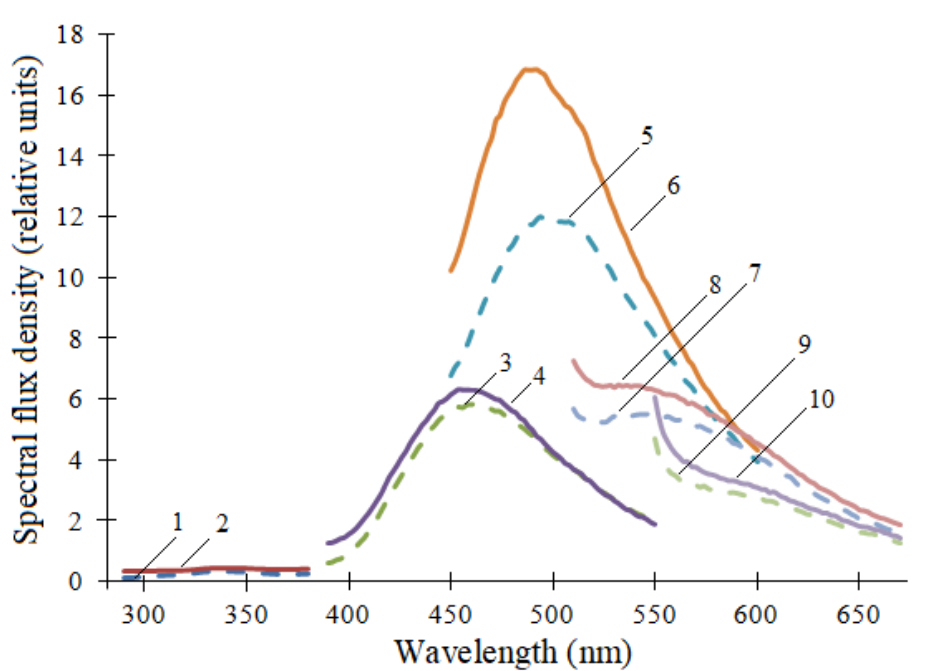
Figure 2. Photoluminescence spectra of oat seeds when excited by radiation: λ e = 232 nm: 1—uninfected, 2—infected; λ e = 362 nm: 3—uninfected, 4—infected; λ e = 424 nm: 5—uninfected, 6—infected; λ e = 485 nm: 7—uninfected, 8—infected; λ e = 528 nm: 9—uninfected, 10—infected. Table 1. Photoluminescence fluxes of plant seeds of various degrees of infection with fusarium. Degree of Infection with Φ 232 , r. Fusarium β , %